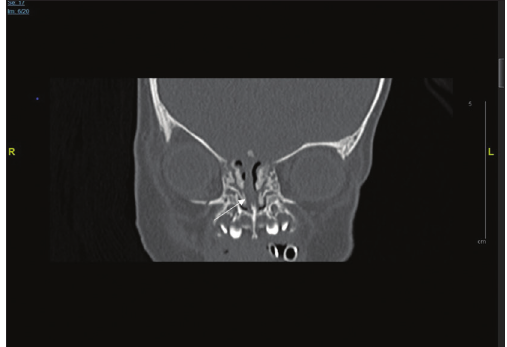
FIGURE 2. Coronal view of the computerized tomography scan shows inferior turbinate hypertrophy causing stenosed nasal cav- ity